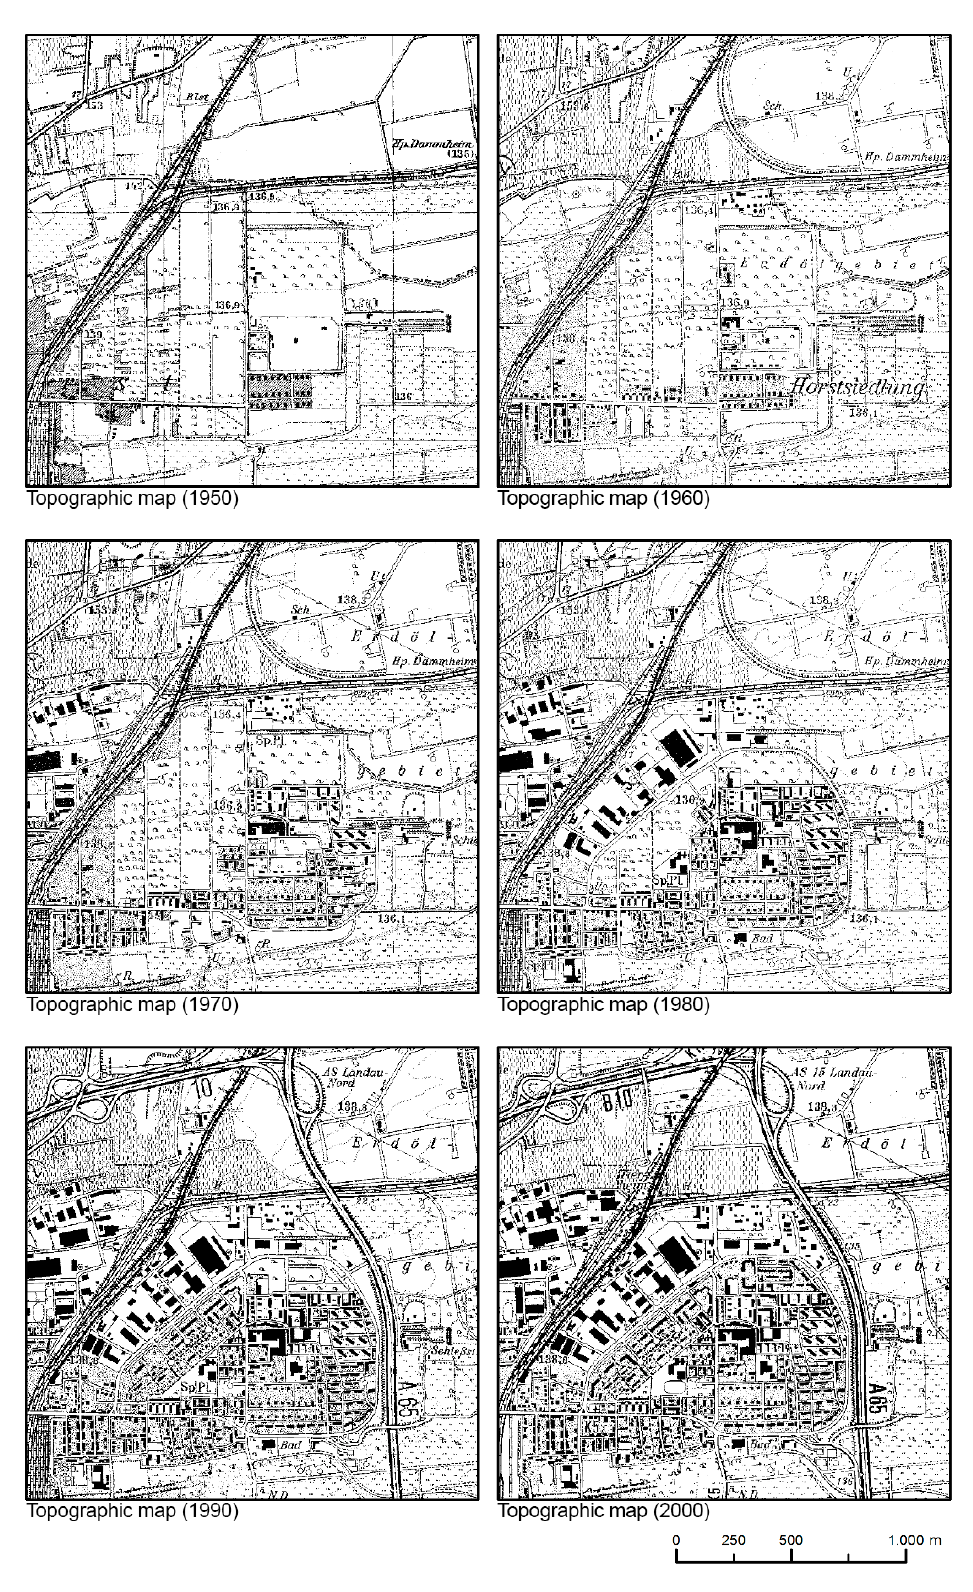
Figure A1. Topographic maps of six different points in time as a basis for the analysis. The map shows a north-eastern part of the City of Landau (Data source: TK25 © LVermGeo 2014).